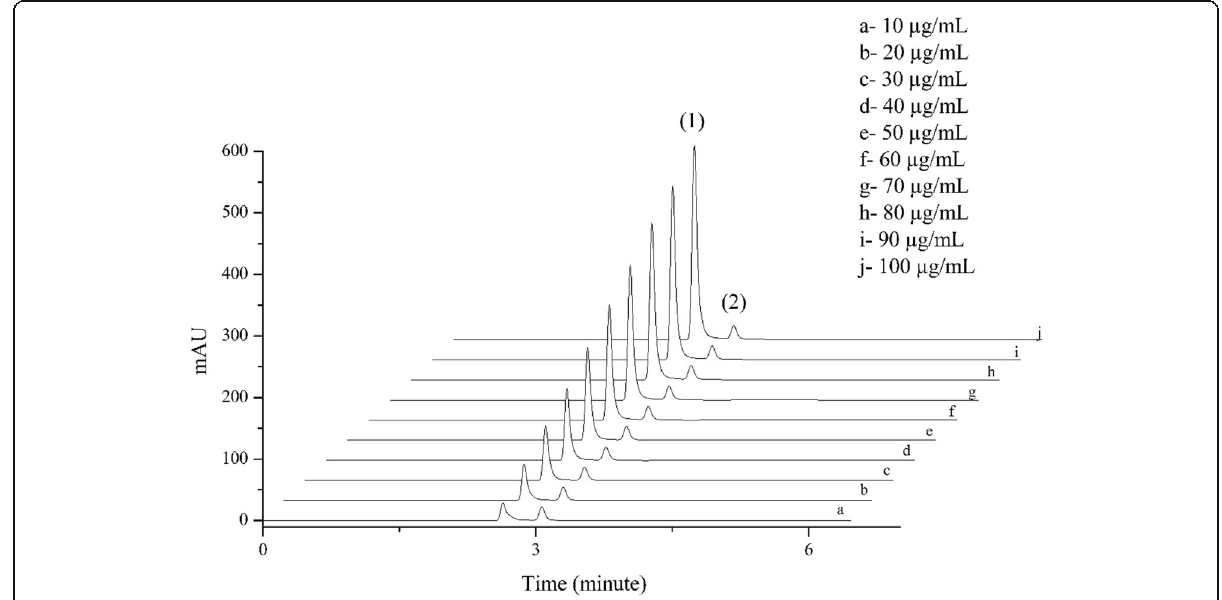
Fig. 9 First derivative spectrums of the tenofovir calibration solutions